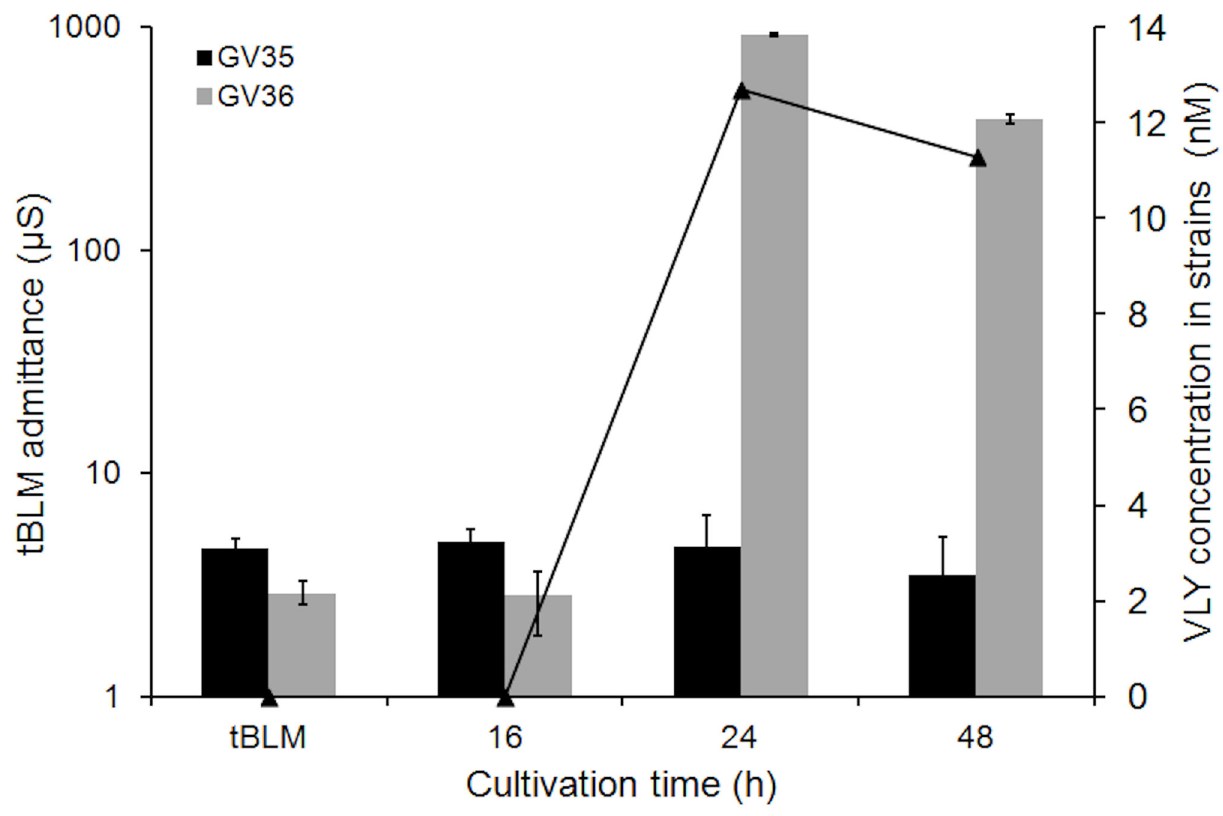
Figure 5. Quantification of VLY production in two G. vaginalis cultures by EIS and ELISA. Variation of the admittance of DOPC/CHOL40% tBLMs upon exposure to VLY in supernatants from two different strains of G. vaginalis (bars). VLY concentration (line) measured by ELISA. Exposure time of tBLM 30 min. Cultivation time of G. vaginalis is indicated under the abscissa. doi: